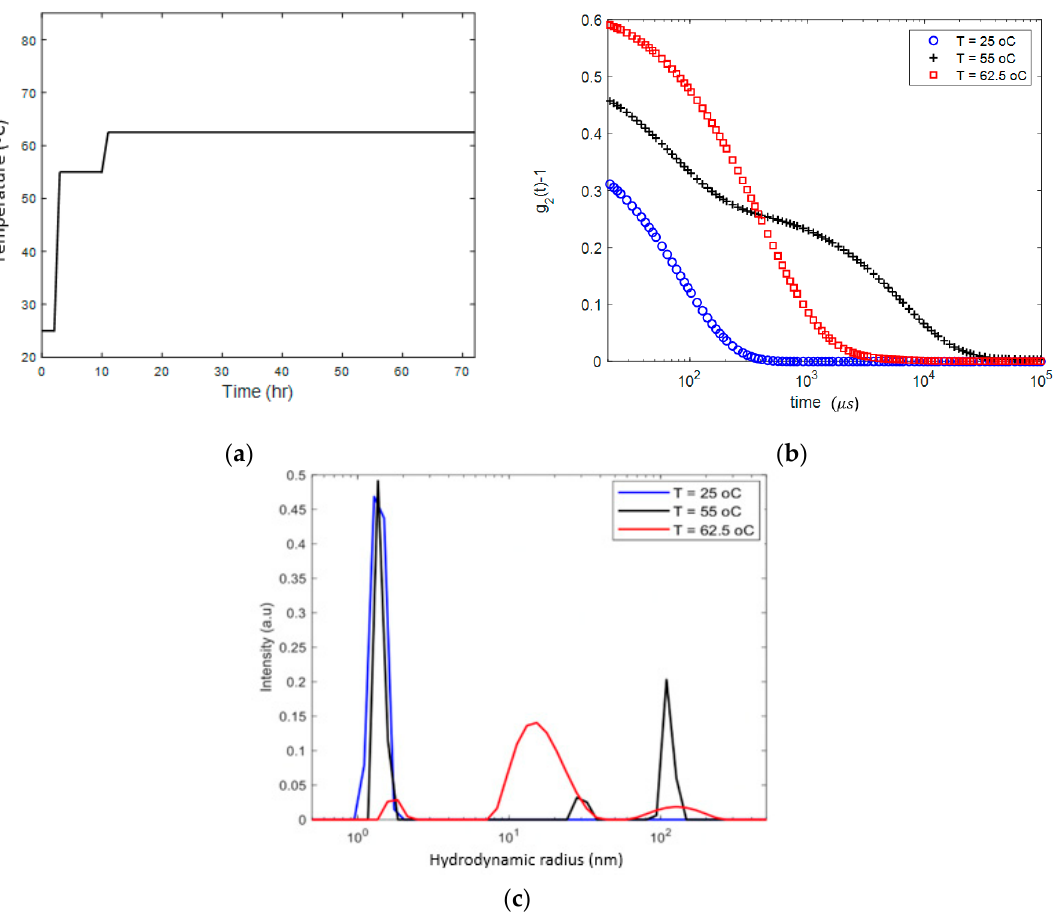
Figure 2. Heating protocol ( a ) and DLS analysis ( b ) and ( c ) demonstrating the process of aggregation and gelation in the 18 mg / mL lysozyme solution, gradually heated to 62.5 ◦ C and kept at this temperature for 60 h. ( b ) DLS autocorrelation function ( θ = 45 ◦ ) before and after gel formation; ( c ) size distribution of the apparent inhomogeneities before and after gelation.